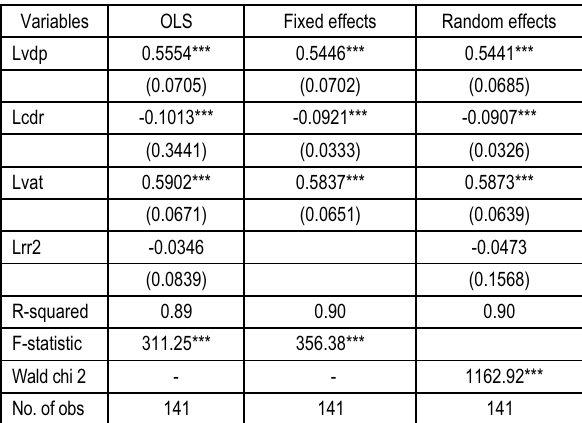
Table 2. OLS, FE & RE Model 1 results with